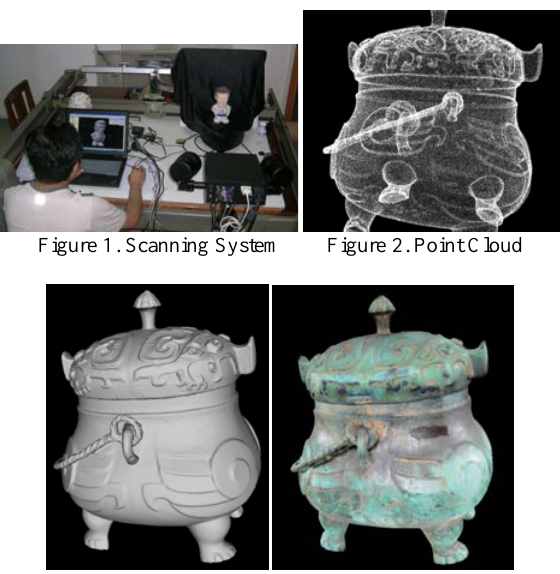
Figure3. 3D Geometry Model Figure 4. 3D Model with